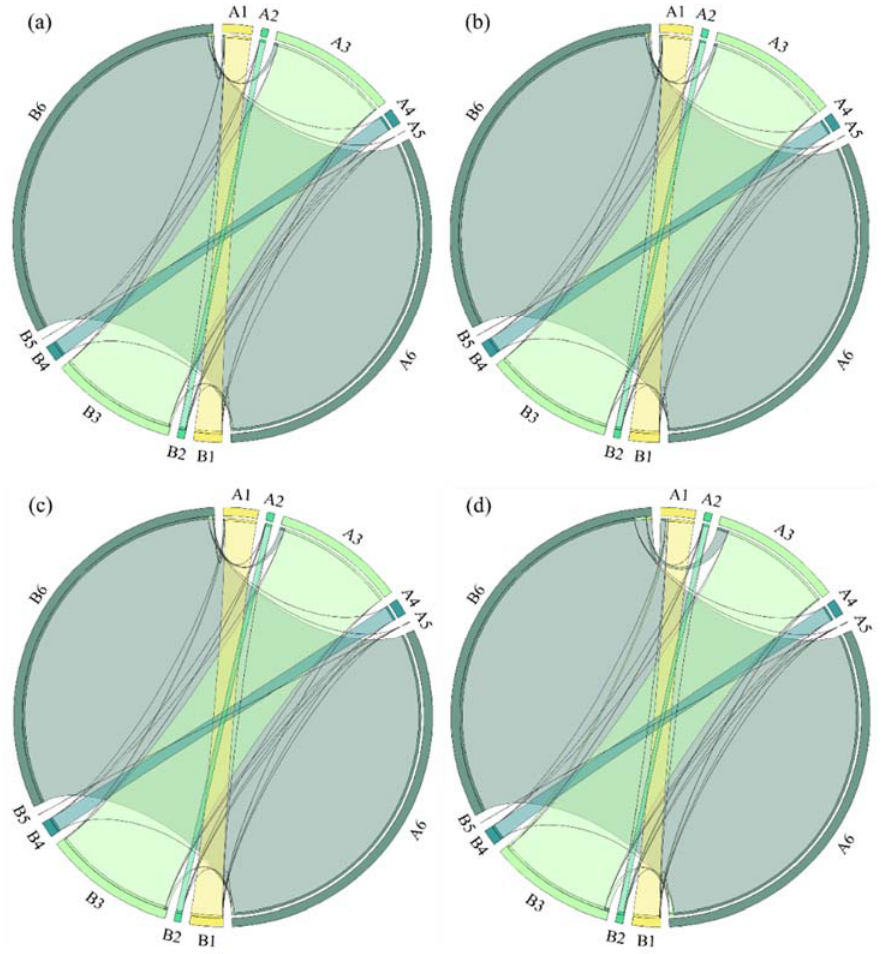
Figure 4. Land use transfer map of the Tarim River Basin from 1992 to 2020. ( a ) 1992–2000, ( b ) 2000–2008, ( c ) 2008–2020, ( d ) 1992–2020. A1–A6 are the land types in the starting years, B1–B6 are land